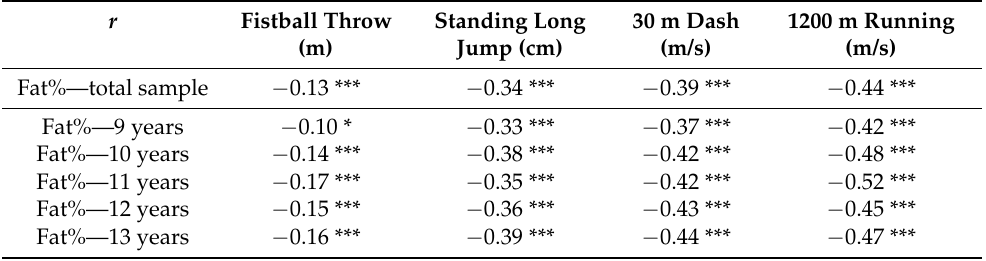
Table 2. Correlation pattern between body fat percentage and physical fitness tests. r Fistball Throw Standing Long (m) Jump